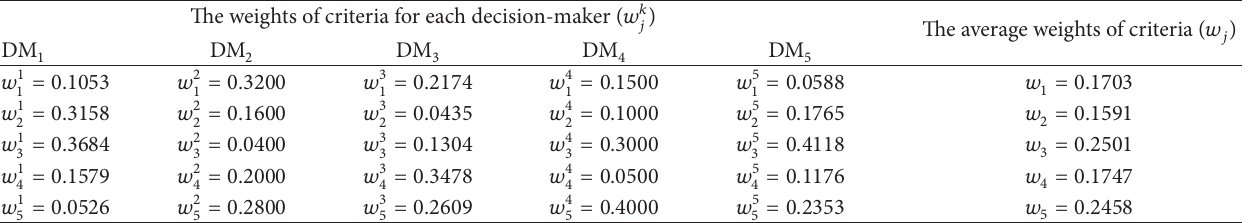
Table 10: Importance weights of evaluation criteria.